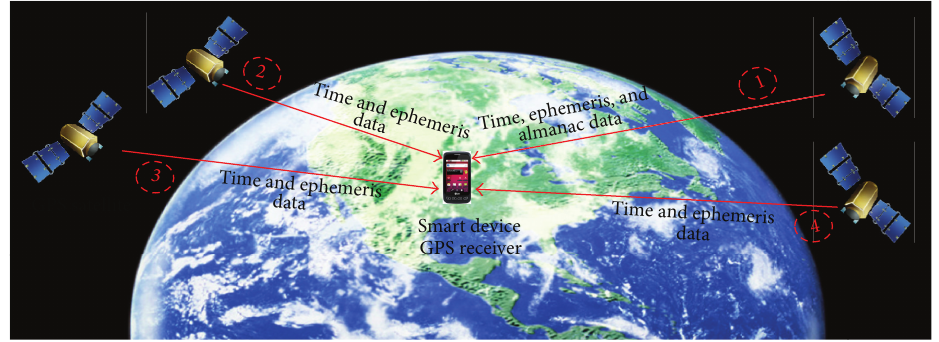
Figure 1: Illustration of Global Positioning